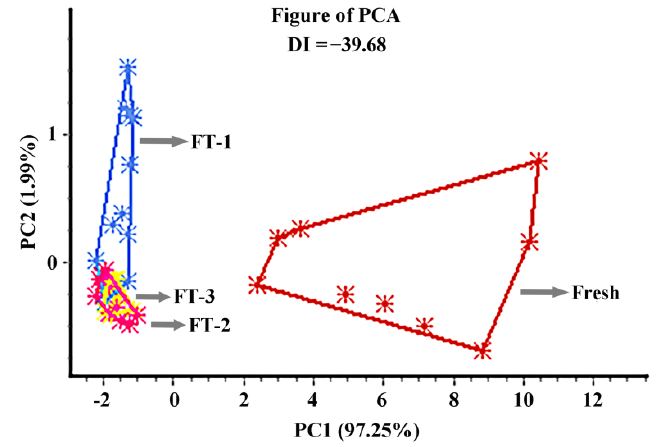
Figure 2. The principal component analysis (PCA) results of freeze-thaw (FT) treated samples. PC1 and PC2 represent the first and second principal component, respectively; FT-1, FT-2 and FT-3 represent the sample with FT treatment once, twice and third times.